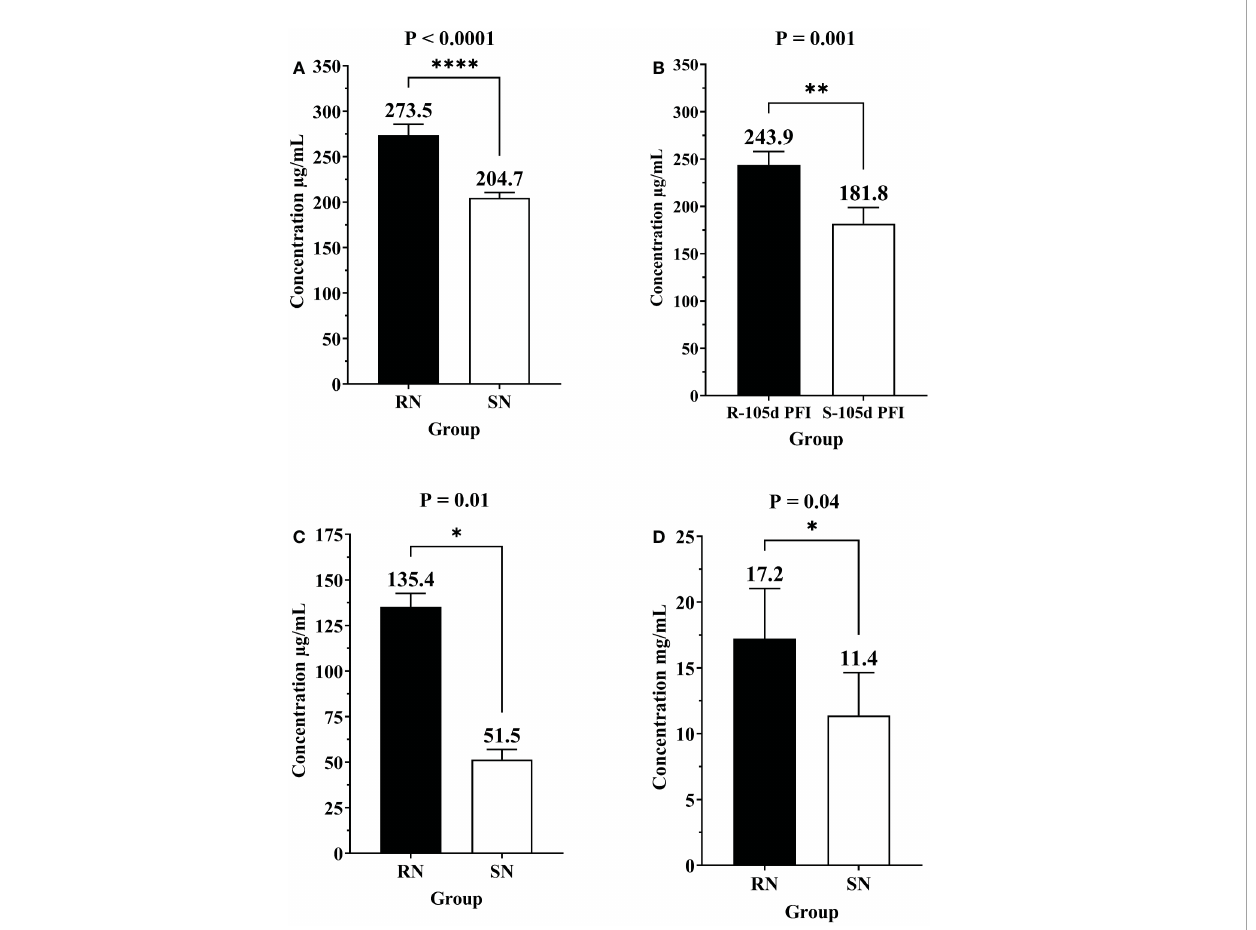
FIGURE 11 Bar graphs showing the concentrations of alpha-1-acid glycoprotein (AGP), conglutinin (CGN1) and immunoglobulin G (IgG) in sera of different groups of cattle measured by commercially available ELISA kits. Concentration of of alpha-1-acid glycoprotein (AGP) in (A) resistant naïve compared to susceptible naïve (RN vs SN), and (B) resistant vs susceptible cattle at 105d PFI (R-105d PFI vs S-105d PFI). Concentration of CGN1 (C) and IgG (D) in resistant naïve compared to susceptible naïve cattle (RN vs SN). Black bars represent resistant cattle; empty bars represent the susceptible group. Asterisk * indicate the level of signi fi cance with * = P ≤ 0.05, ** = P ≤ 0.001, and **** = P ≤